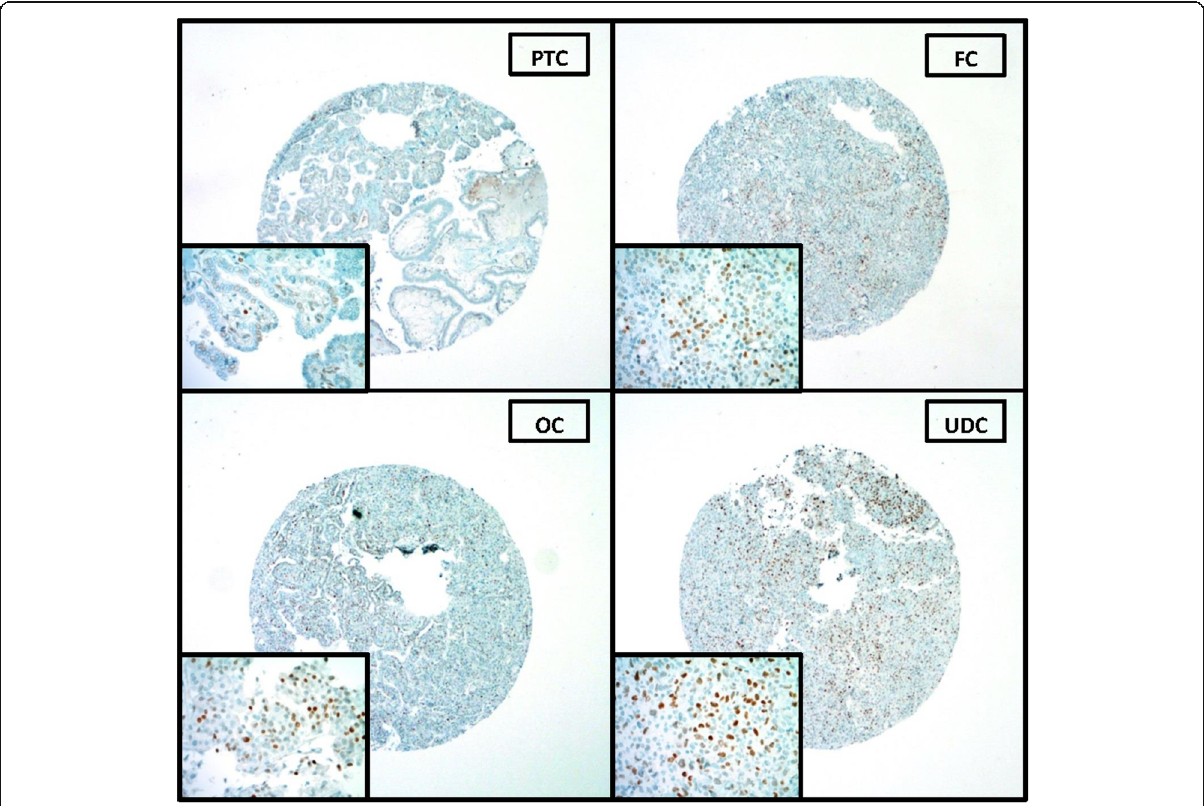
Fig. 1 cMYC nuclear expression by immunohistochemistry in a spectrum of follicular cell-derived carcinomas (representative TMA images). cMYC expression was observed in a nuclear pattern. The original magnification of the whole TMA cores was 4X, with the photomicrographic insets taken at 40X. In this image, PTC showed >25% cells staining weakly for cMYC (scores 2 & +1, respectively), FC had a score of 2 & +2, OvFC had 3 & +2 score and UDC showed diffuse, mostly strong staining with a score of 4 & +3